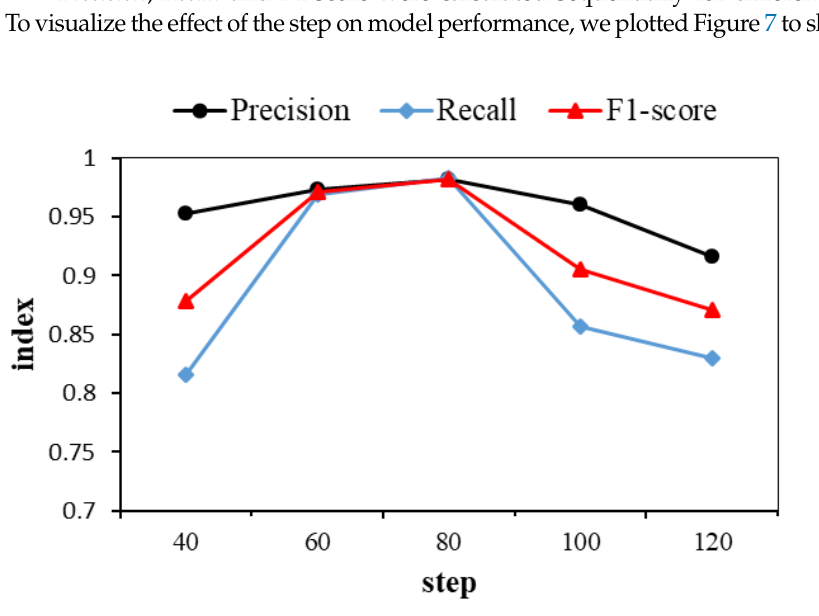
Figure 7. Effect of step on Precision , Recall , and F 1-score. Figure 7 represents the effect of the step of sliding window on model